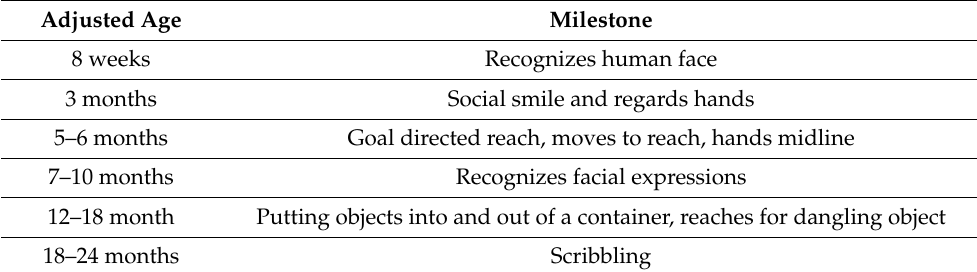
Figure 1. Hiding Heidi Contrast test (Good-Lite, Elgin, IL, USA). ( A ) The cards from highest (100%, top left) to lowest (1.25%, bottom right) contrast, where the % contrast can be seen at the bottom right hand corner of each card. ( B ) During testing, the Hiding Heidi Contrast card would be revealed under a white card and the examiner would look for shift of gaze or head turn toward the visual stimuli, here the card with 5% contrast is shown. Table 1. Expected visual milestones based on age [17,18].